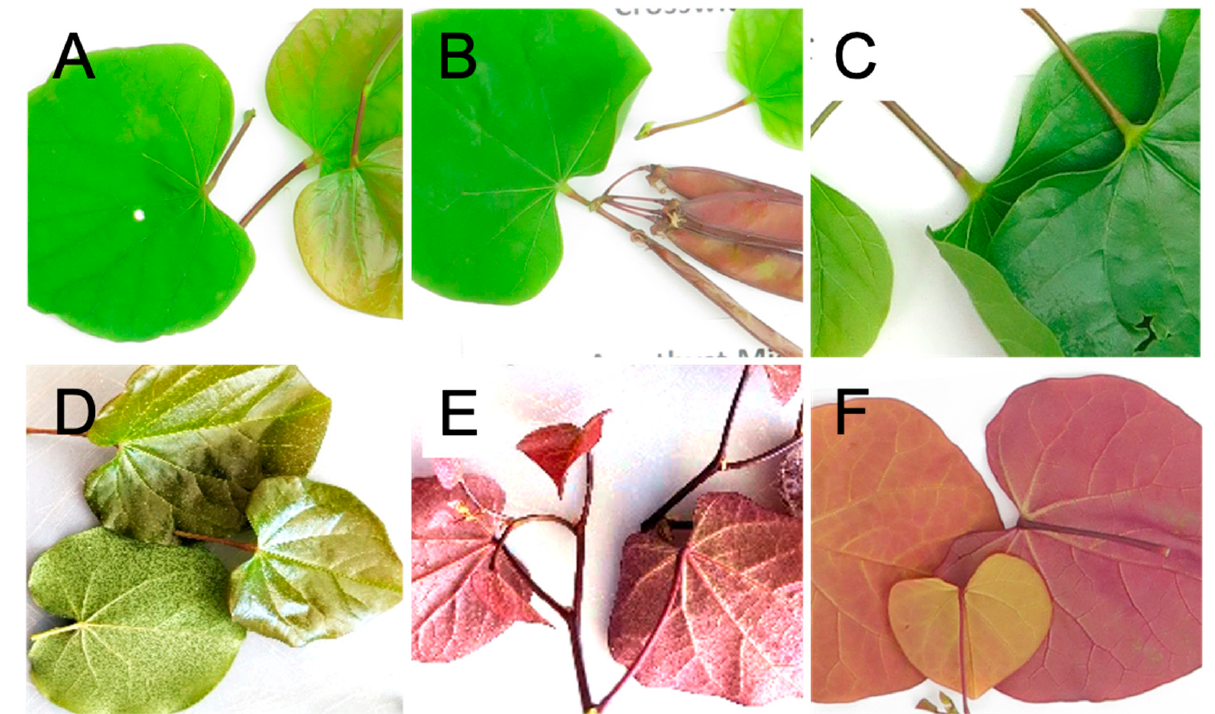
Figure 2. Leaves and petioles of C. canadensis cultivars: ( A ) ‘Appalachian Red’, ( B ) ‘Crosswick’s Red’, ( C ) ‘Traveller’, ( D ) ‘Oklahoma’, ( E ) ‘Ruby Falls’, ( F ) Flame Thrower.